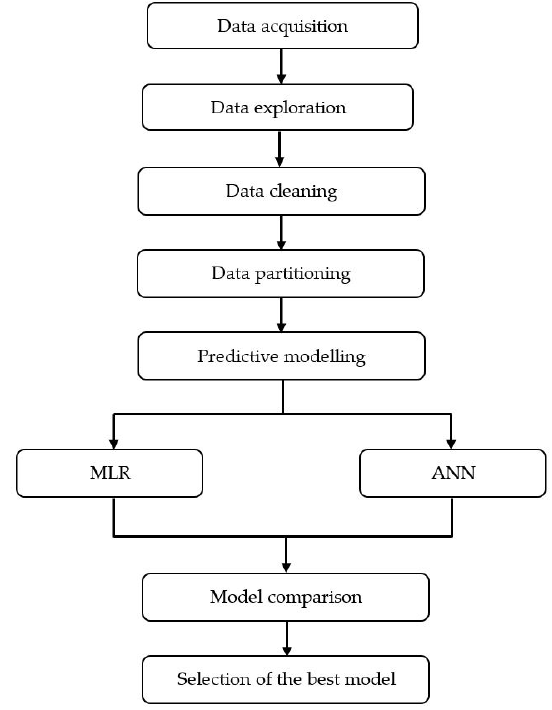
Figure 1. Modeling